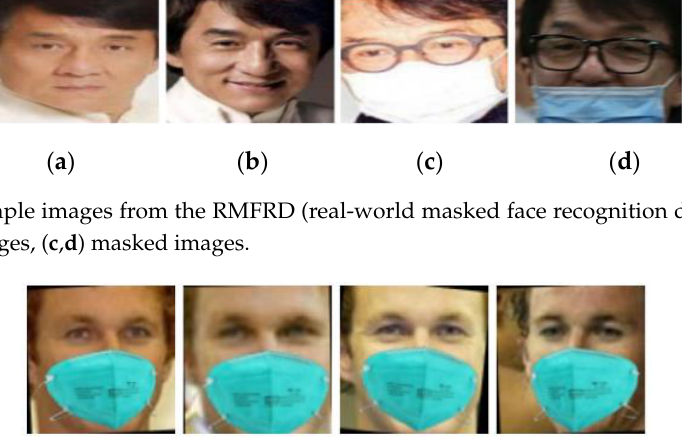
Figure 17. Example images from the RMFRD (real-world masked face recognition dataset) dataset: ( a , b ) typical images, ( c , d ) masked images. 3.